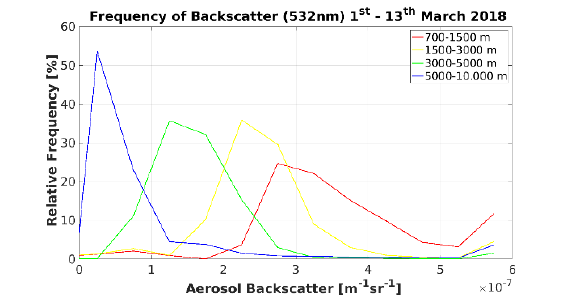
Fig.01 : Distribution of aerosol backscatter in different altitude